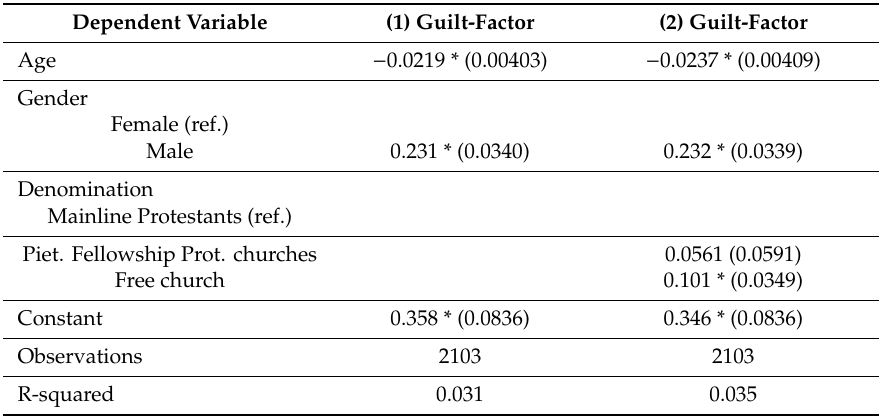
Table 10. Key Outcome Multiple Linear Regression (other e ff ects on the highly religious Protestant adolescents and young adults experiencing the